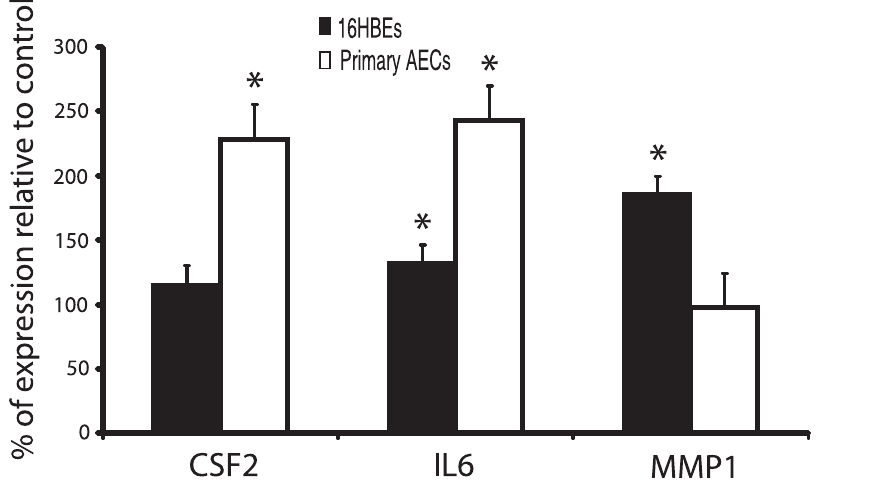
Figure 2. Relative mRNA expression levels of human genes obtained by RT-qPCR. RNA was obtained from four co-incubations each of 16HBE14o- (grey bars) or primary normal bronchial epithelial cells (AECs) (white bars) with conidia of A. fumigatus . Height of each bar represents expression of gene in co-incubated condition relative to cells alone control (mean 6 SE). (* p , 0.05).